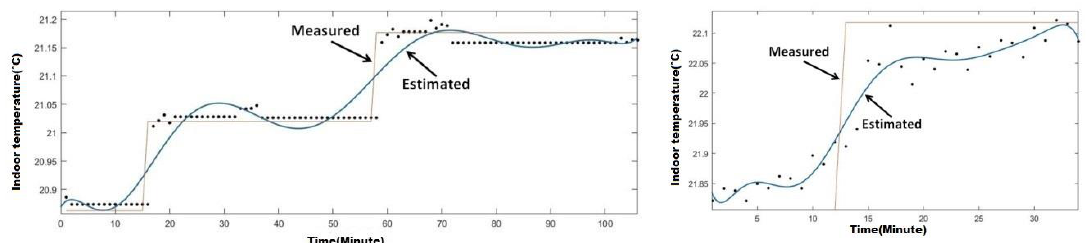
Figure 6. Model-based, one-step predicted indoor temperature time history when the living space is empty (left-side) and when it is fully occupied (right-side).